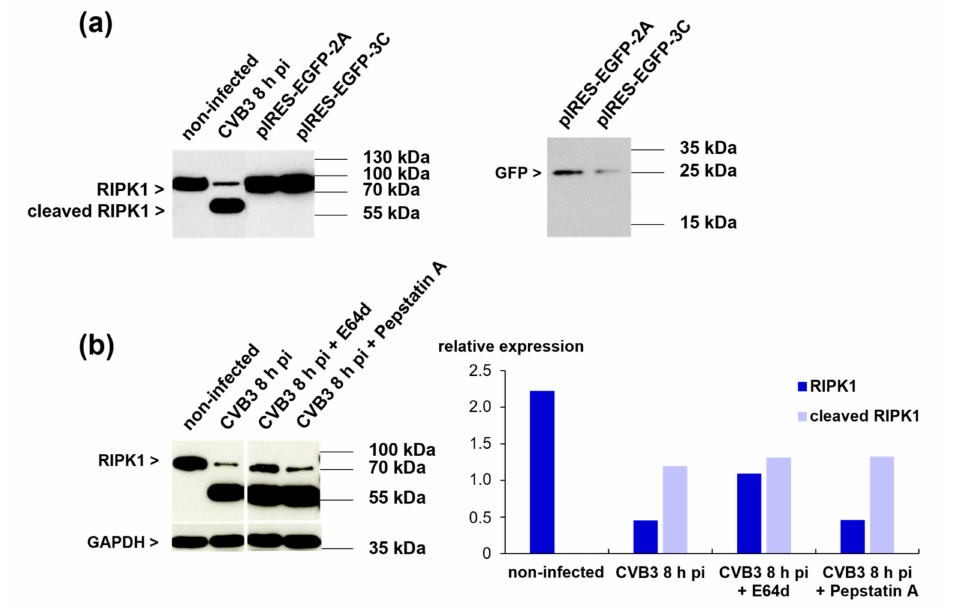
Figure 7. ( a ) Western blot analysis of RIPK1 expression in iCell ® Cardiomyocytes transfected with either pIRES-EGFP- 2A or pIRES-EGFP-3C (left panel). GFP expression is shown in the right panel. ( b ) Western blot analysis of RIPK1 expression in CVB3-infected iCell ® Cardiomyocytes eight hours pi (MOI 10) after pre-incubation with the protease inhibitors E64d or pepstatin A. iCell ® Cardiomyocytes were pre-incubated for one hour with the inhibitors before CVB3 infection. Densitometric analysis is shown in the right panel. Data were normalized to